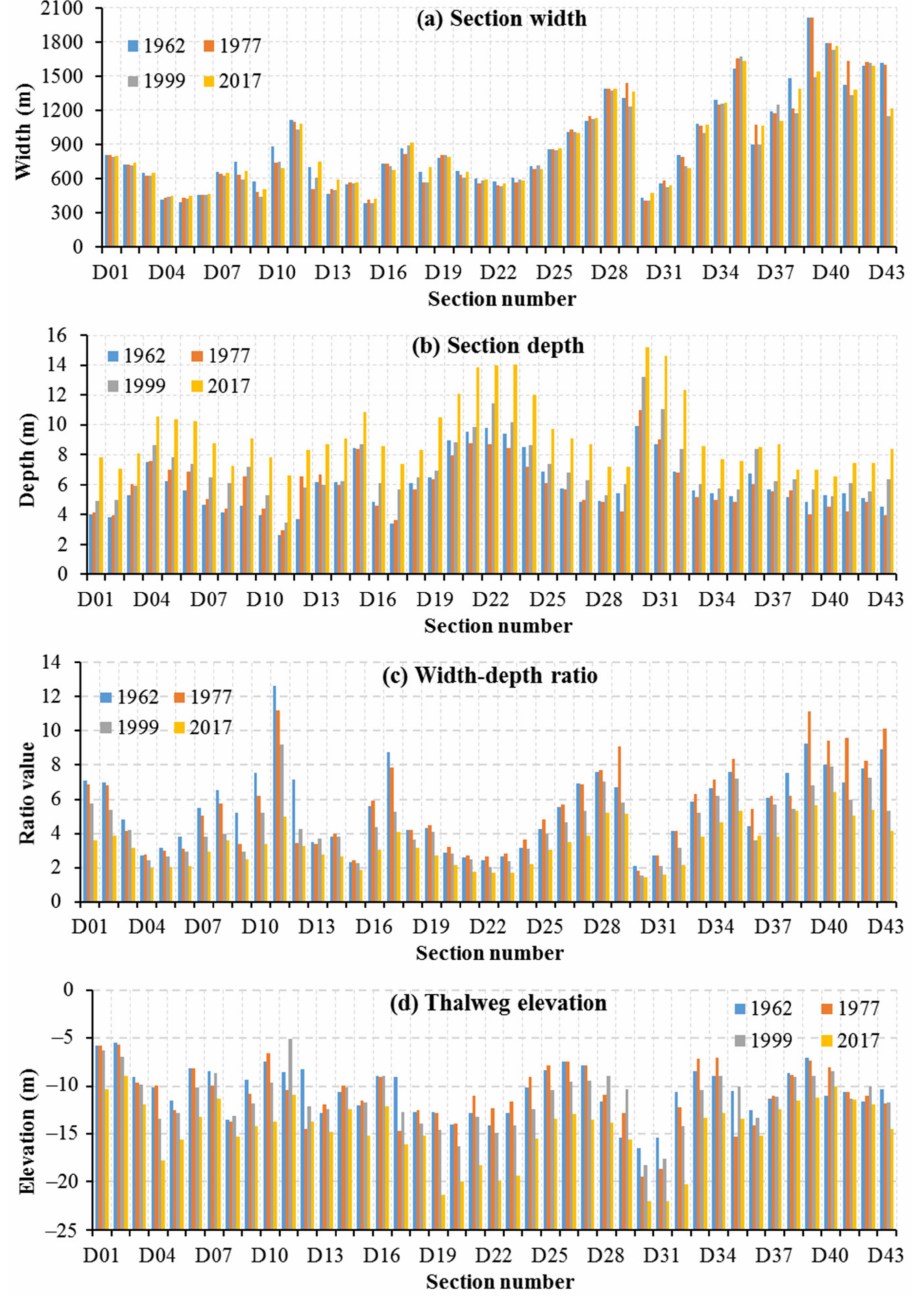
Figure 7. Section width ( a ), section depth ( b ), width-depth ratio ( c ), and thalweg elevation ( d ) of the cross-sections along the Modaomen Channel from 1962 to